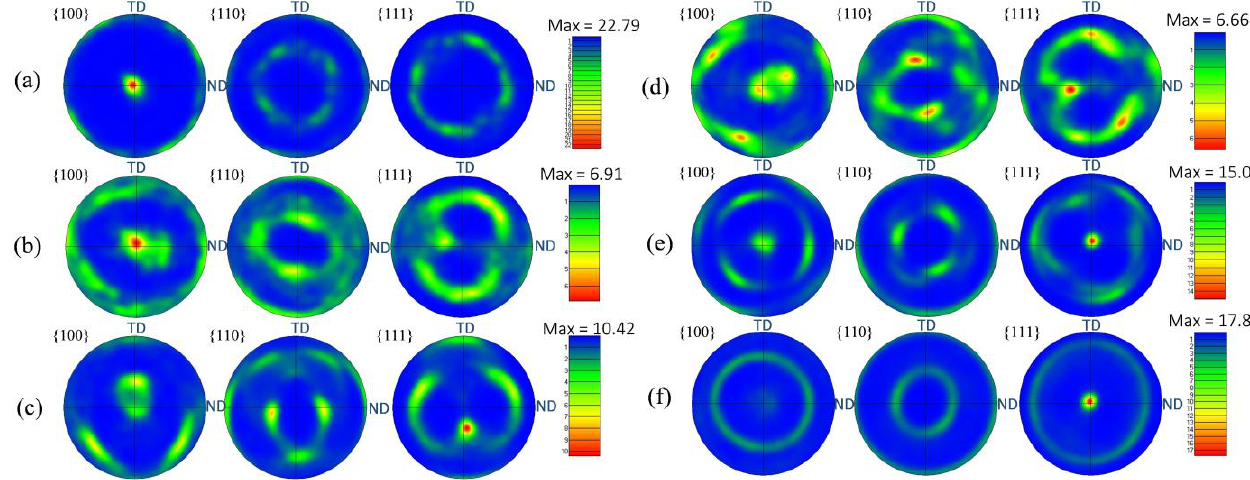
Figure 14. Pole figures of the composites with different drawing reductions: ( a ) 36.0%, ( b ) 67.3%, ( c ) 73.6%, ( d ) 81.6%, ( e ) 91.3%, ( f ) 99.7%.